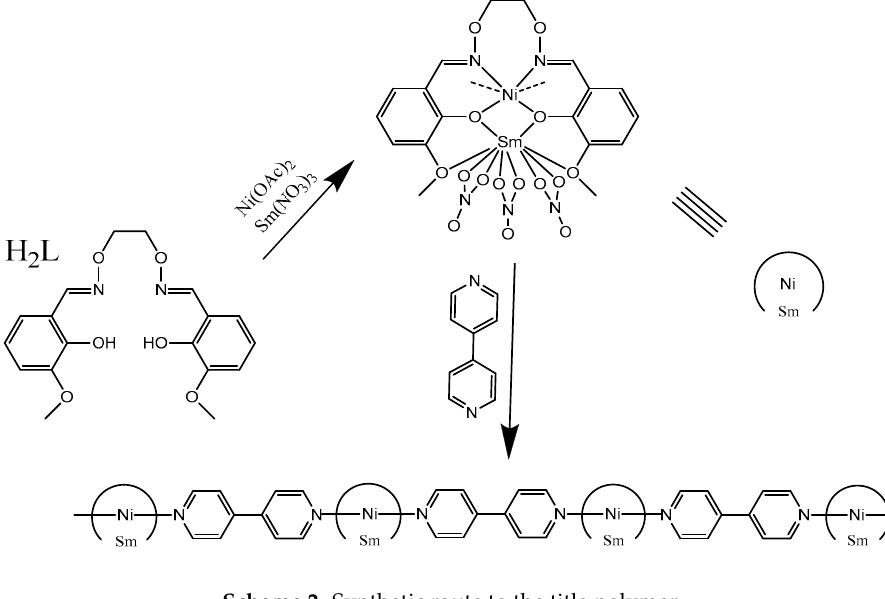
Scheme 2. Synthetic route to the title polymer.